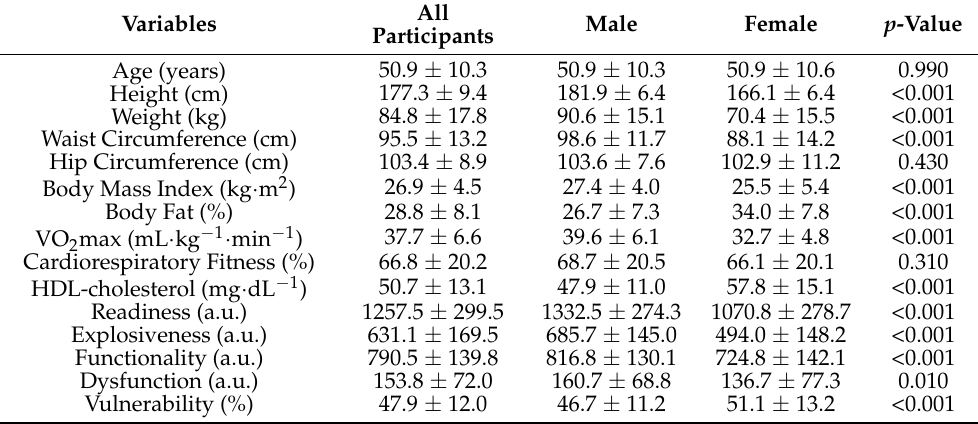
Table 2. Demographic data and health-related physical fitness test results (x ± SD).